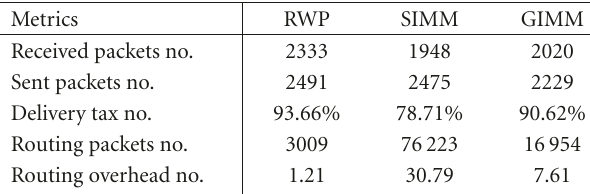
Table 5: The influence of mobility in the DSR